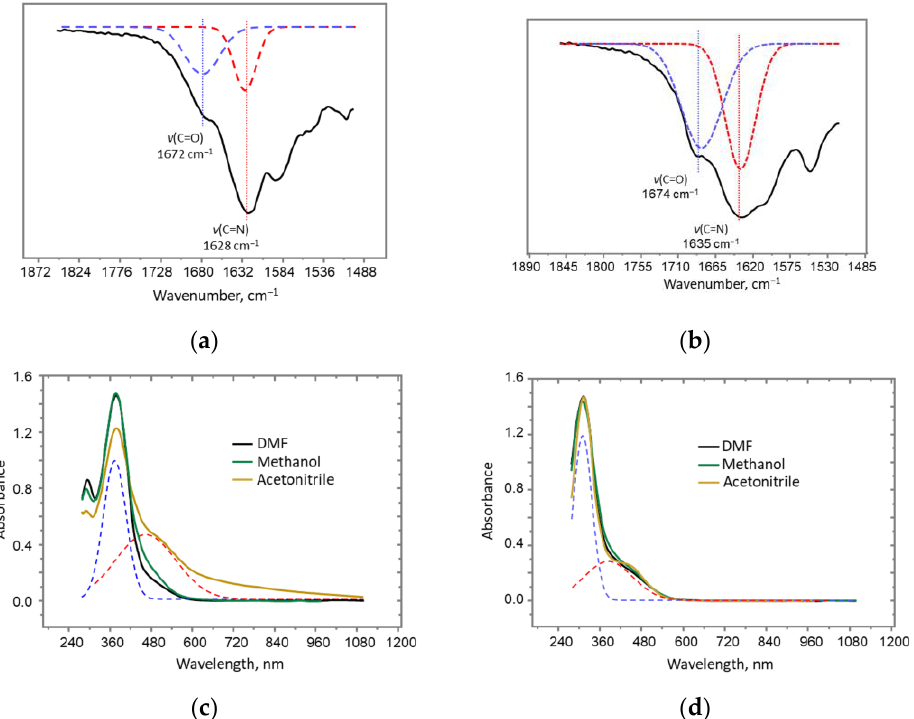
Figure 1. ( a , b ) Fragments IR spectra of ( a ) salRA and ( b ) dmaeRA; ( c , d ) UV spectra of ( c ) salRA and ( d ) dmaeRA in DMF, methane and acetonitrile (dotted line indicates bands for imine- (blue) and keto-groups (red)), C = 0.04 mM.